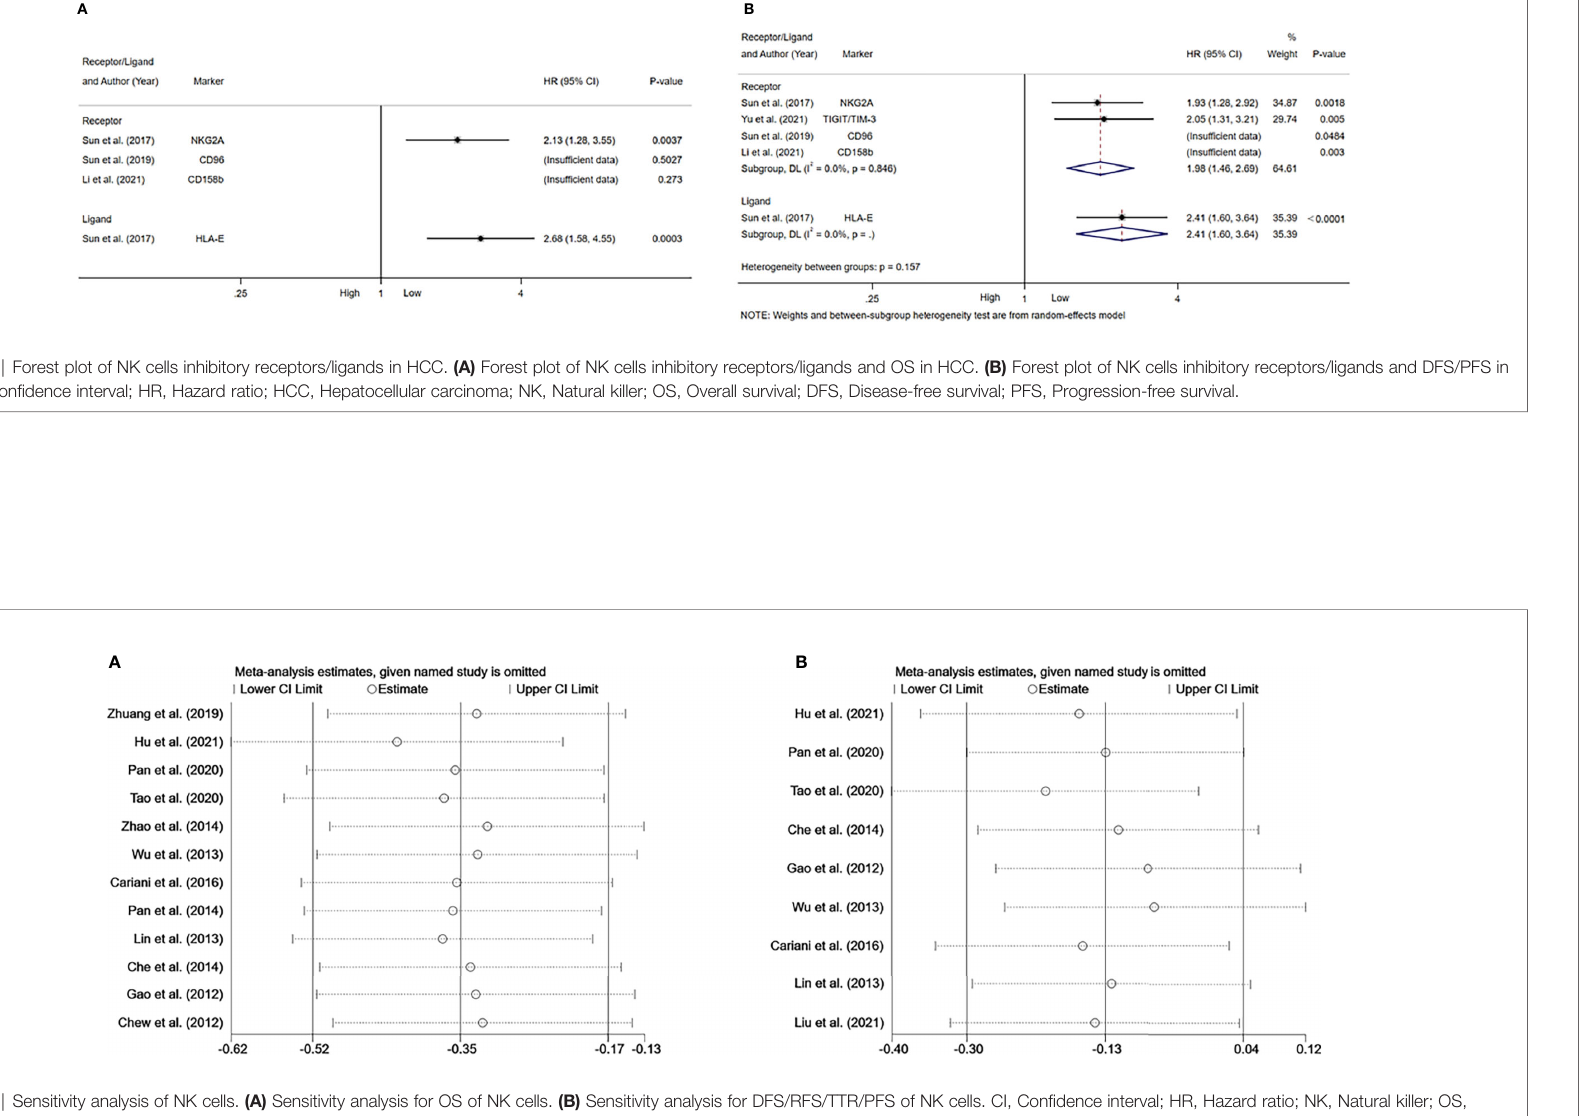
FIGURE 6 | Sensitivity analysis of NK cells. (A) Sensitivity analysis for OS of NK cells. (B) Sensitivity analysis for DFS/RFS/TTR/PFS of NK cells. CI, Con fi dence interval; HR, Hazard ratio; NK, Natural killer; OS, Overall survival; DFS, Disease-free survival; RFS, Recurrence-free survival; TTR, Time-to recurrence; PFS, Progression-free